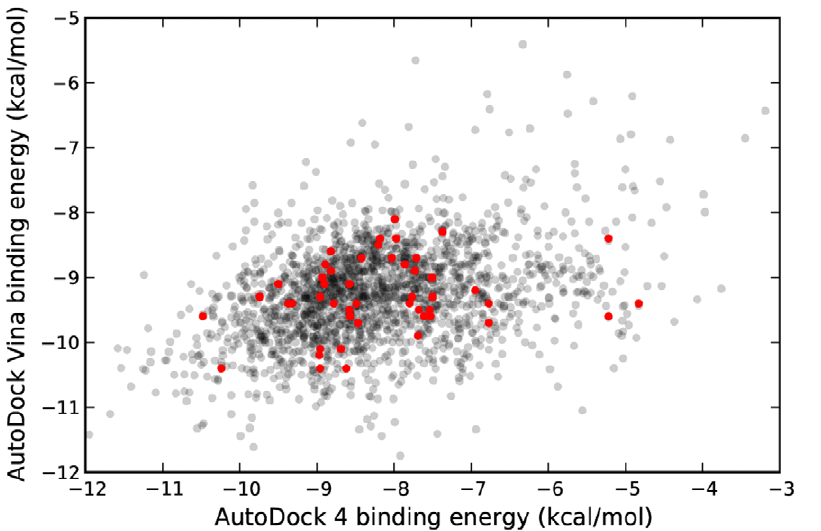
Figure 7. Predicted binding energies for DUD compounds with HIV protease as determined by AD4 and Vina. No significant correlation was observed. Active compounds are highlighted in red.